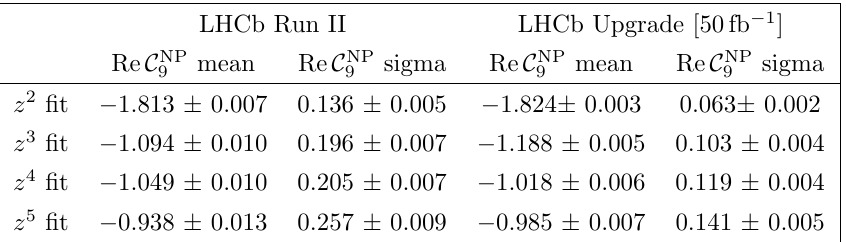
observable obtained from z 2 , z 3 , 9